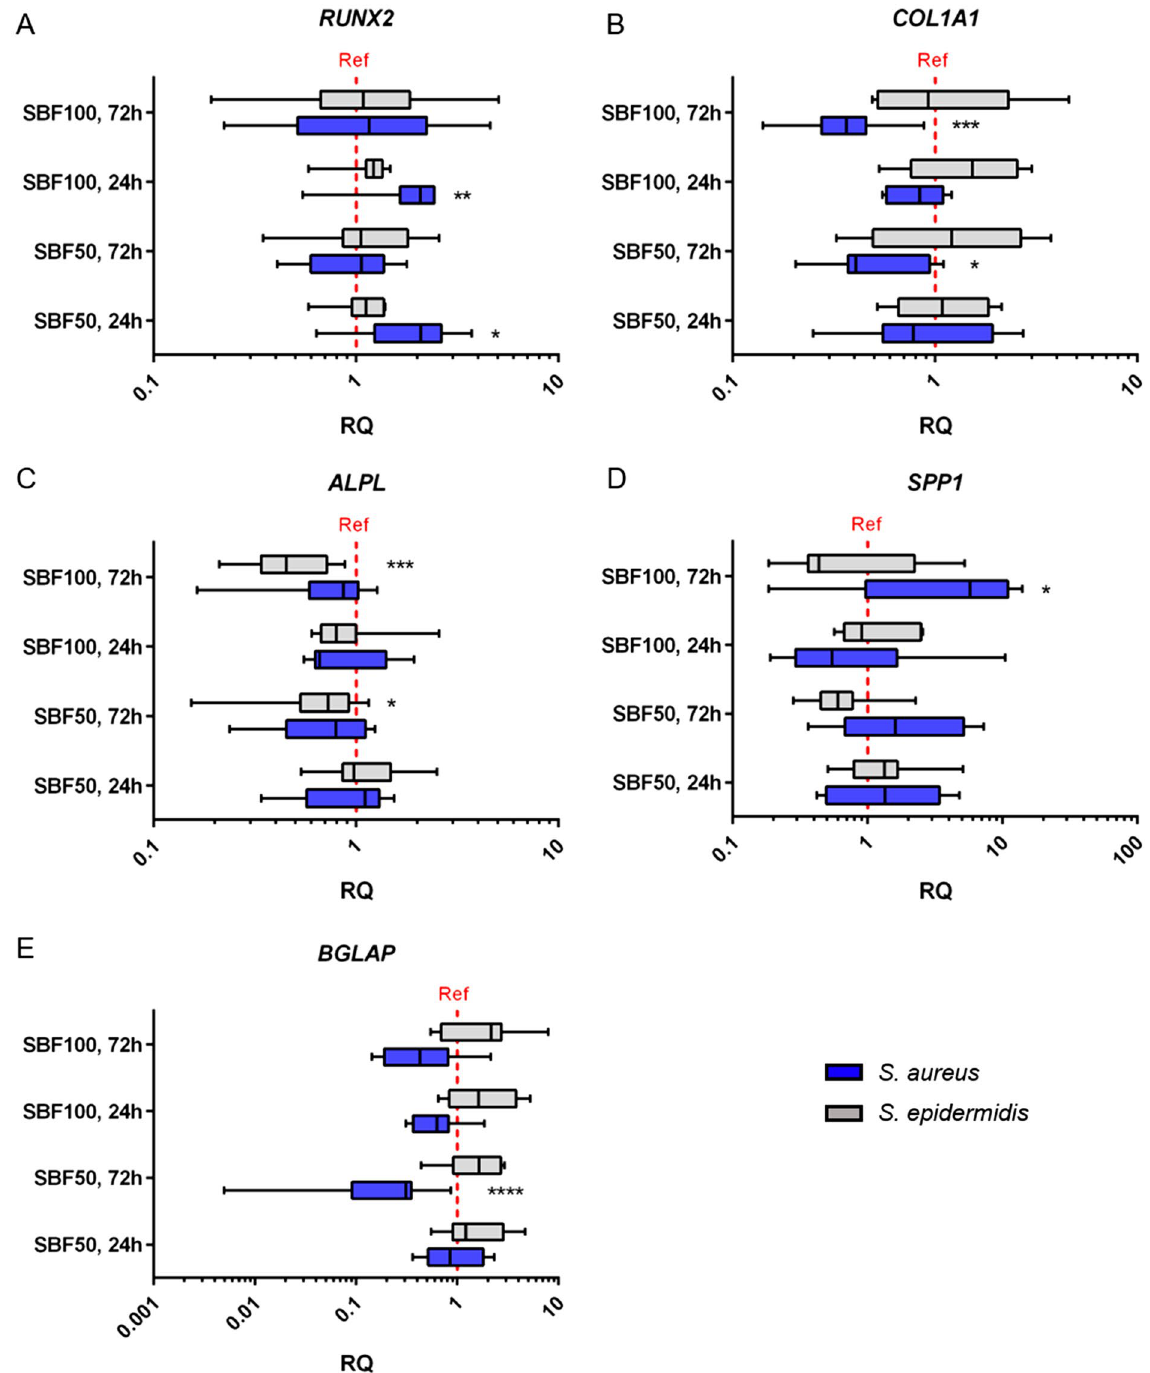
Figure 4. Gene expression changes of genes involved in osteogenic differentiation after stimulation with SBF. qPCR revealed the influence of S. aureus or S. epidermidis soluble factors (SBF50, 24 h; SBF50, 72 h; SBF100, 24 h; SBF100, 72 h) on genes of osteogenic differentiation. CO served as reference (red grid line). RUNX2 : ( A ); COL1A1 : ( B ); ALPL : ( C ); SPPL : ( D ); BGLAP : ( E ). The results are presented as relative quantification compared to the CO group. The one sample t-test for a null hypothesis (H 0 = 1) was done. *p ≤ 0.05, **p ≤ 0.01, ***p ≤ 0.001, ****p ≤